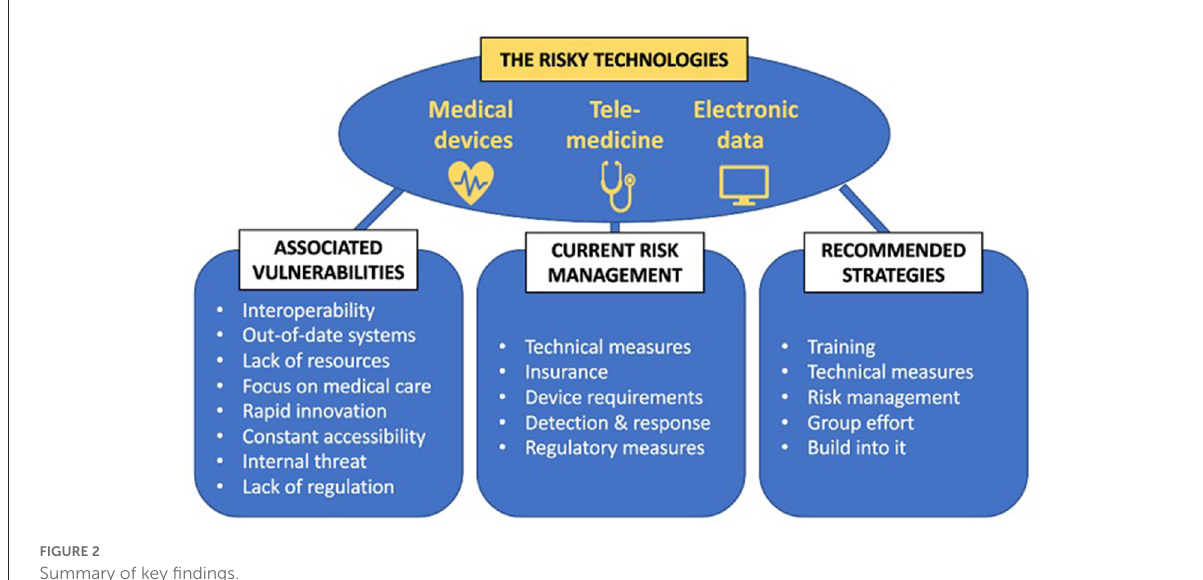
FIGURE2 Summary of key